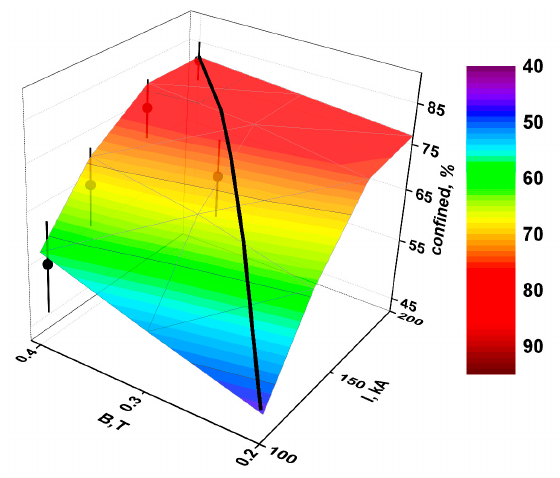
Figure 10. Dependence of the fast ion fraction that has not undergone direct losses on I p and B T for the case of 18 keV H NBI. Experimental estimate of the confined fraction is shown by dots. Modeling results are represented by the surface. Black line represents the border of the I p / B T > 500 kA/T region, where instabilities related to a decrease in safety factor near the plasma boundary occur. The figure is taken from [46] and reproduced with permission from IOP Publishing.